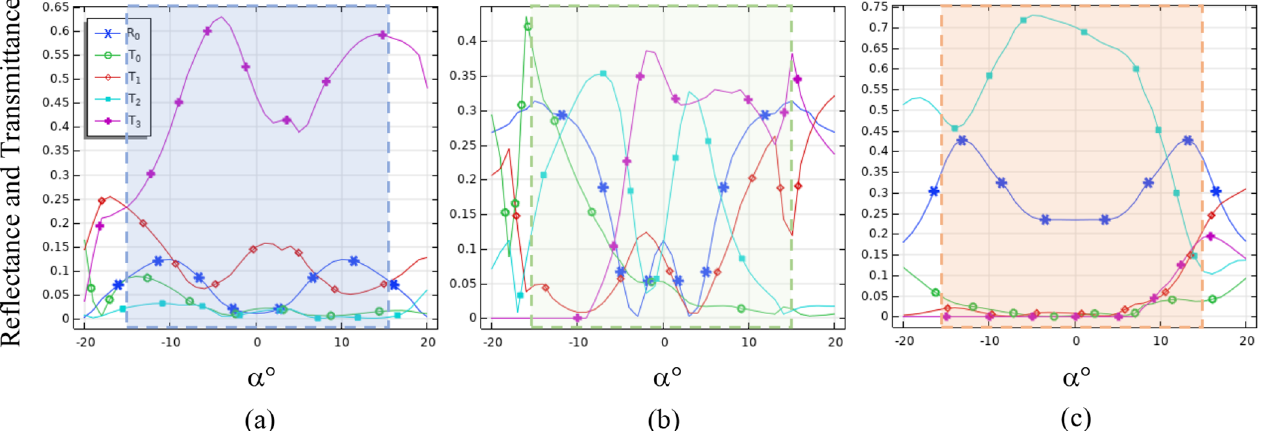
Fig. 12. Diffraction performance of the TiO 2 /AlAs transmissive metasurface using the unit cell depicted in Figure 10 for an example set of parameters for (a) blue, (b) green and (c) red